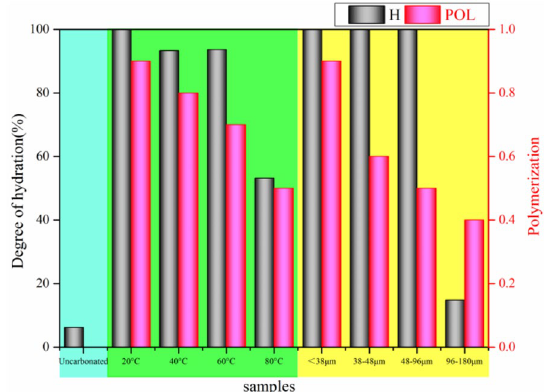
Figure 7. Hydration and polymerization degree of C 2 S and C 3 S at different reaction temperatures or with different LFS particle